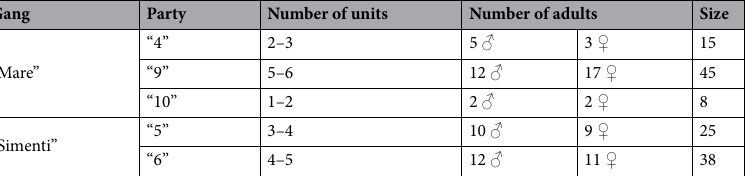
Table 6. Average composition of study parties. Party sizes (i.e. total number of party members) varied due to births, deaths, disappearances, between-parties transfers of individuals, and difficulties in recognizing young weaned